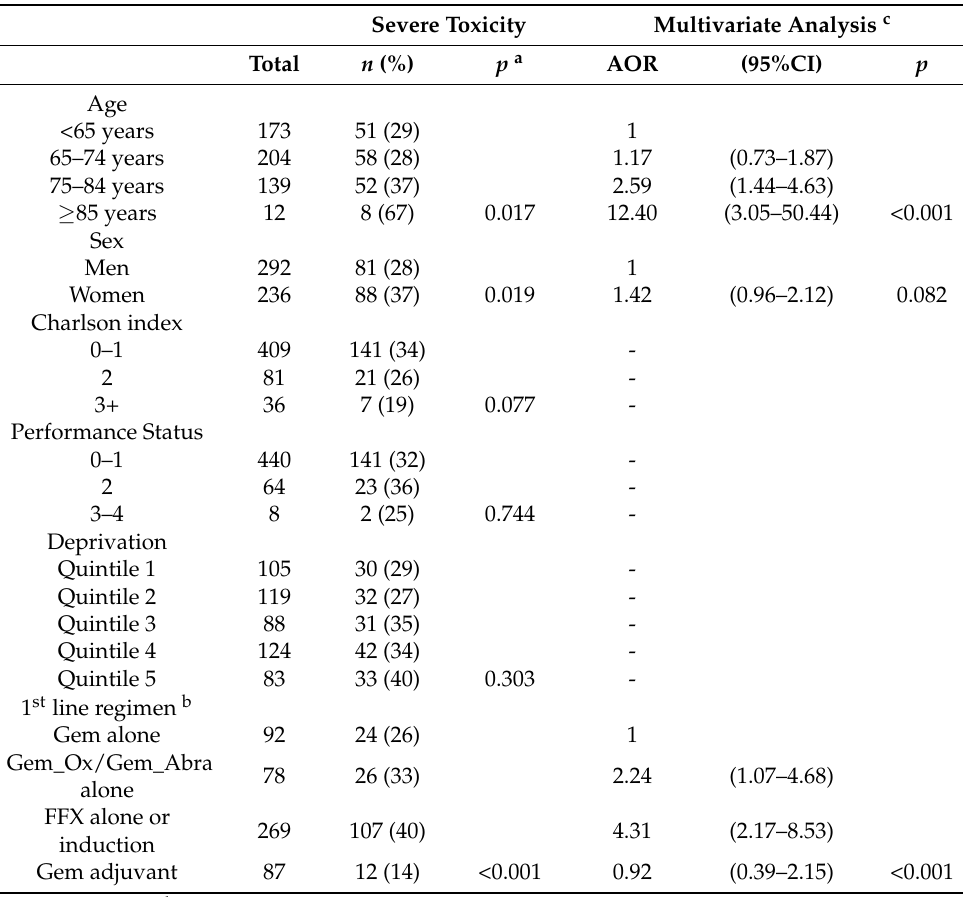
Table 4. Occurrence of severe toxicity leading to a change in or interruption of chemotherapy regimen among patients receiving chemotherapy for pancreatic cancer ( n =